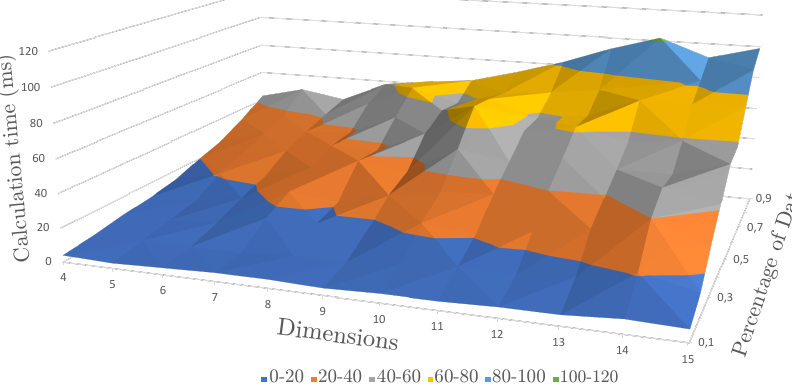
Figure 10. Calculation times for the conducted PCA. In the worst case, the computation takes around 100 ms to calculate the principal